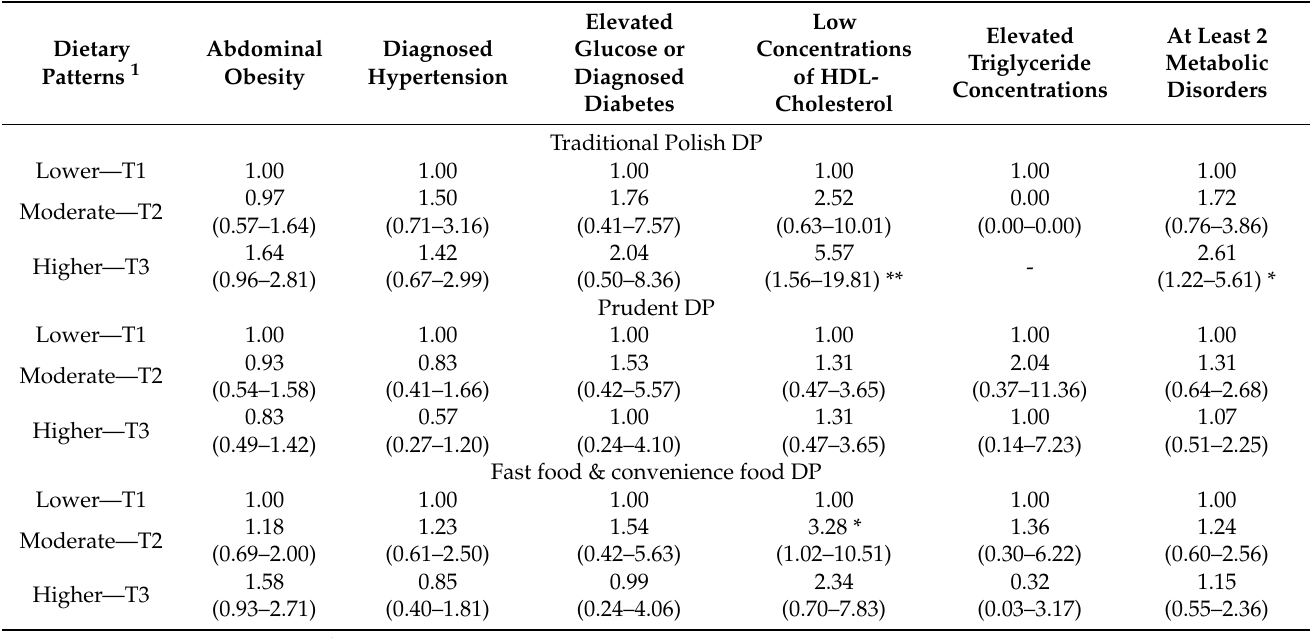
Table 6. Crude associations between dietary patterns (DPs) and adiposity and metabolic abnormali- ties: odds ratios (95% Confidence Intervals (95%CIs).